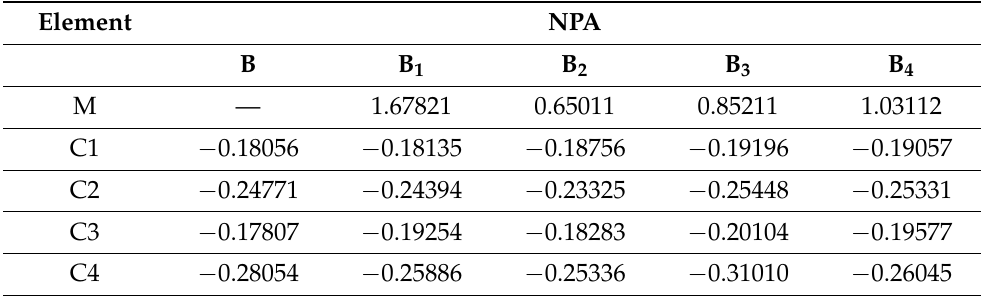
Table 6. Atomic charges in terms of the natural population analysis (NPA) of the H 2 L ligand and its metal complexes using B3LYP/6-311G and B3LYP/LANL2DZ, respectively.